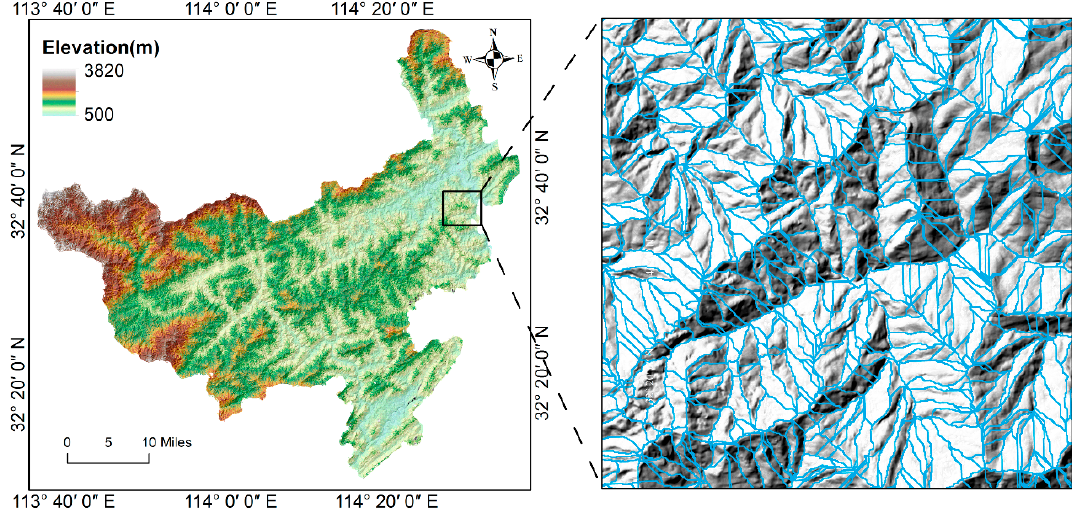
Figure 3. Schematic diagram of spatial proximity expression in slope units .